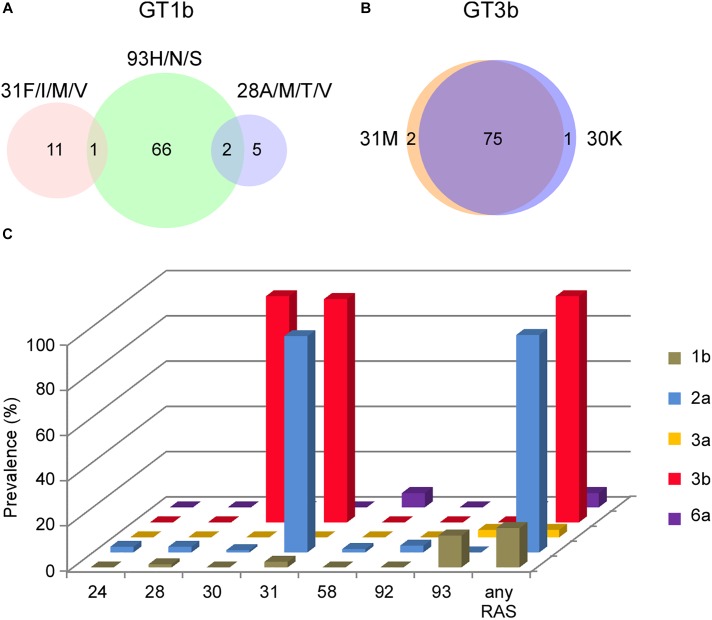
Coincidence of RASs distribution. (A) NS5A 28A/M/T/V, 31F/I/M/V and 93H coexistence in GT1b sequences by Venn diagram. (B) NS5A 30K and 31M coexistence in GT3b sequences by Venn diagram. Sample numbers were labeled in the diagram. (C) Prevalence of RASs detected in NS5A by subtypes. NS5A RASs definition (Wei L. et al., 2018) include: 1b: L28M/V, L31I/F/M/V, P58D, A92K and Y93C/H/N/S; 2a: T24G/N/R/S, F28A/C/G/L/T, K30E/G/H/R/T, L31I/F/M/V, P58D/S, C92K/N/S/T and Y93C/F/H/N/S; 3a or 3b: S24G/N/R, M28A/G/T, A30E/G/H/K/R, L31I/F/M/V, P58D/G, E92T and Y93C/F/H/N/S; 6a: Q24G/N, F28A/G/M/T/V, R30E/G/H/K/L/T, L31I/F/M/V, T58A/D/G/S, A92K/T and T93A/C/F/H/N/S.